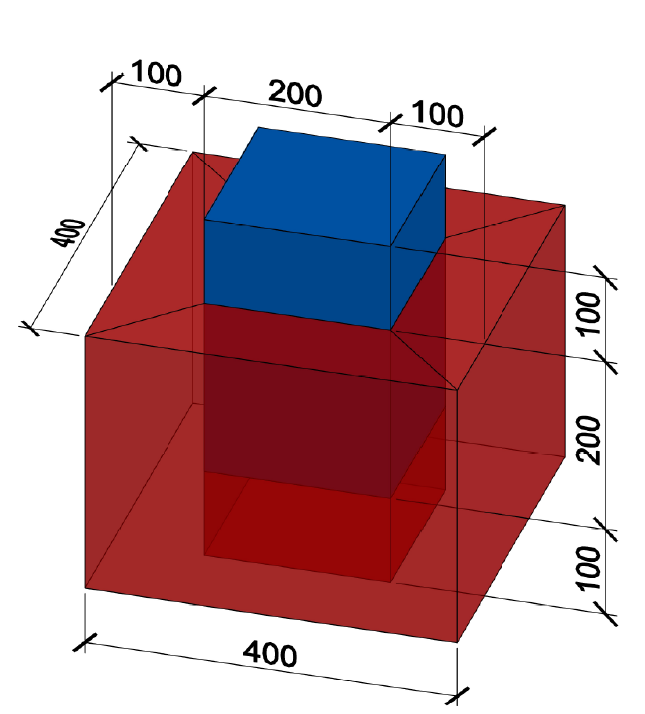
Figure 6. Box specimen, red colour indicates UHPC, blue colour indicates NSC and empty space under the NSC part is filled with